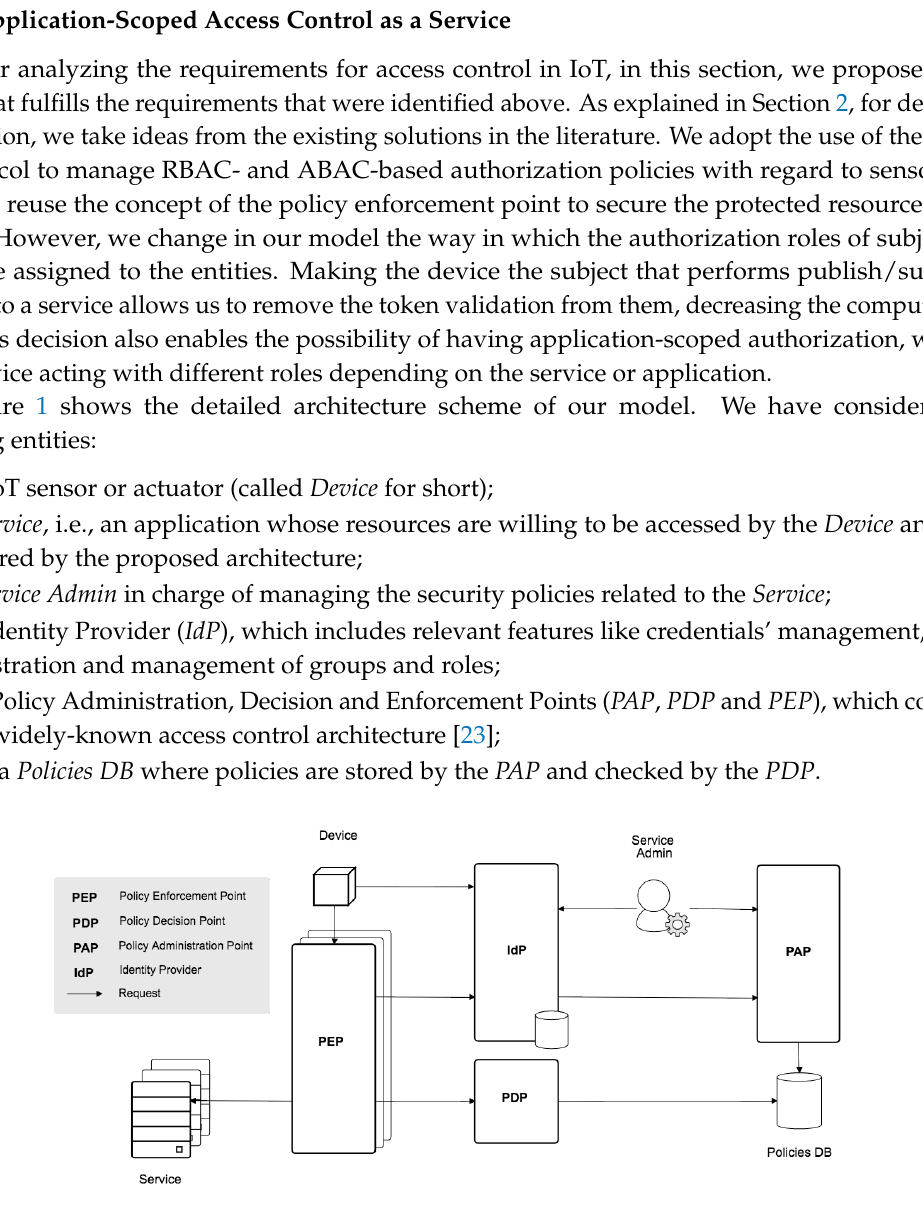
Figure 1. As a service access control